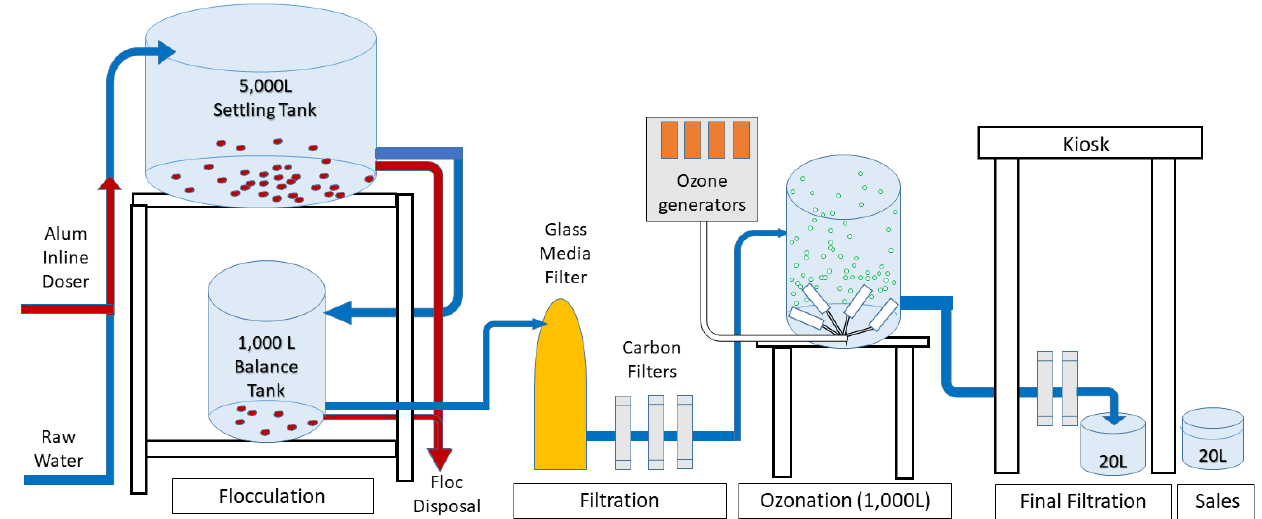
Figure 1. Schematic diagram of the water treatment system.